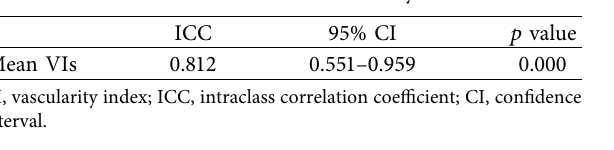
Table 1: Test-retest